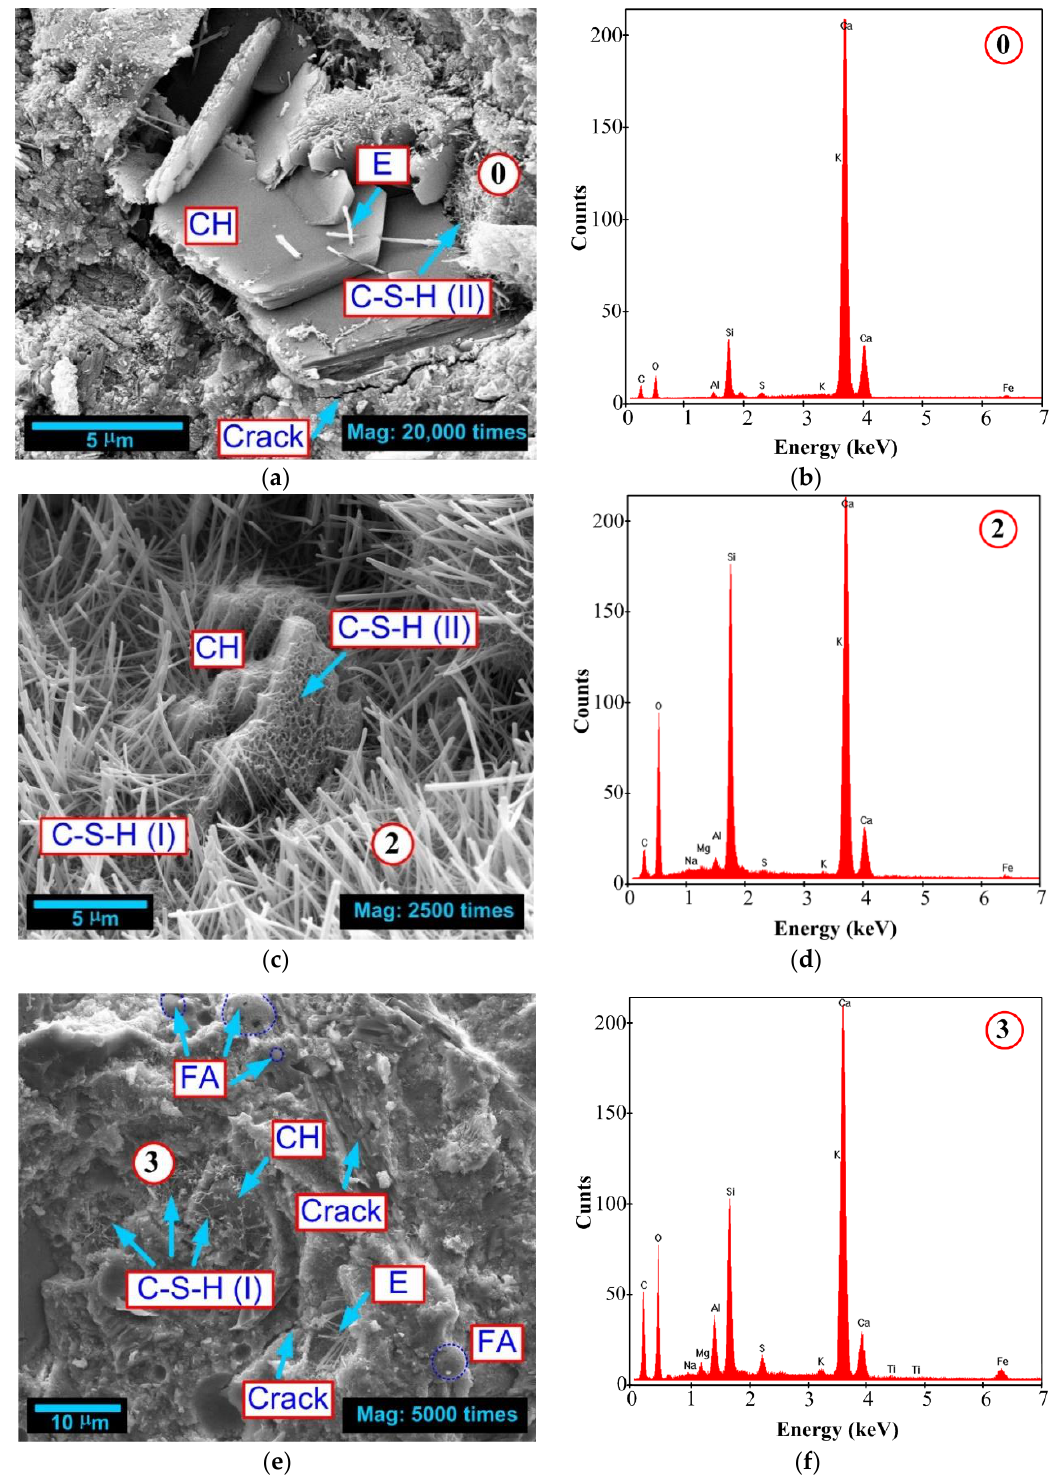
Figure 14. Microstructure of studied concrete specimens with EDS analyses after 28 days of curing: ( a , b ) LCFA-00; ( c , d ) LCFA-20; ( e , f ) LCFA-30.